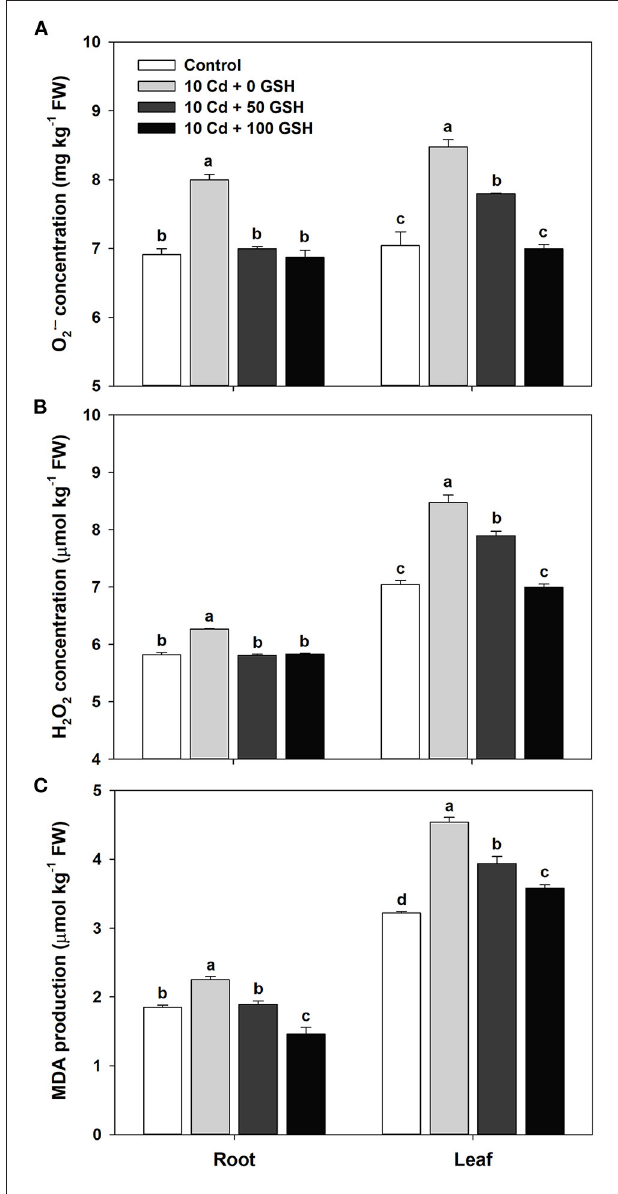
FIGURE 2 | (A) Superoxide (O •− 2 ), (B) hydrogen peroxide (H 2 O 2 ), and (C) malondialdehyde production (MDA) (C) in the roots and leaves of oilseed rape plants grown under control (no Cd or GSH) or 10 µ M Cd stress conditions and sprayed with/without GSH (0, 50, and 100mg kg − 1 ). Reactive oxygen species (ROS) and MDA concentration were measured 10 days after treatment. Means denoted by the same letter are not significantly different at the P < 0.05 level according to Fisher’s least significant difference (LSD)